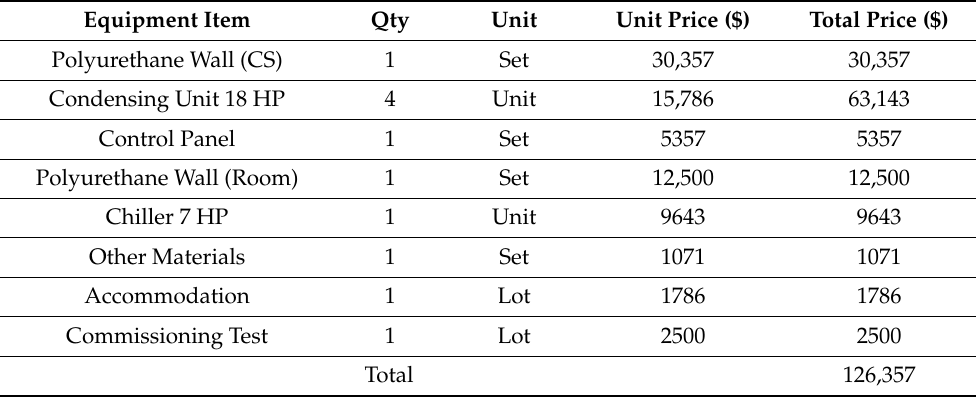
Table 1. Cold Storage’s Material and Installation Costs.